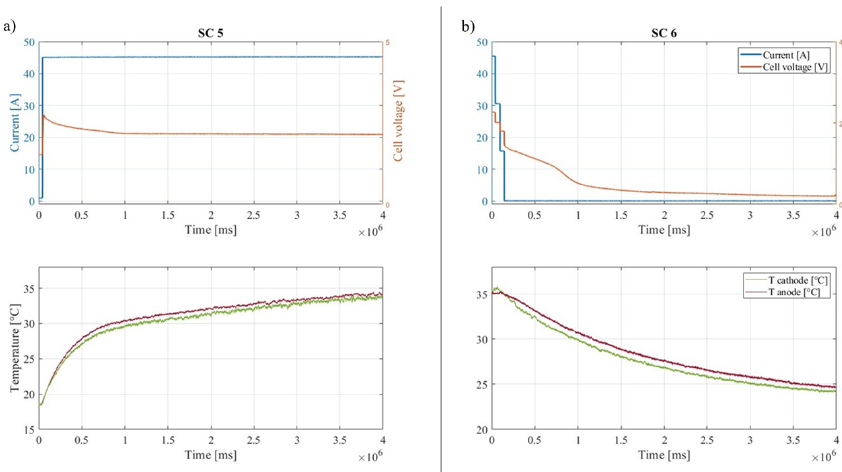
Figure 8. Obtained experimental results: ( a ) SC5 (0–45 A), and ( b ) SC6 (45–0 A).